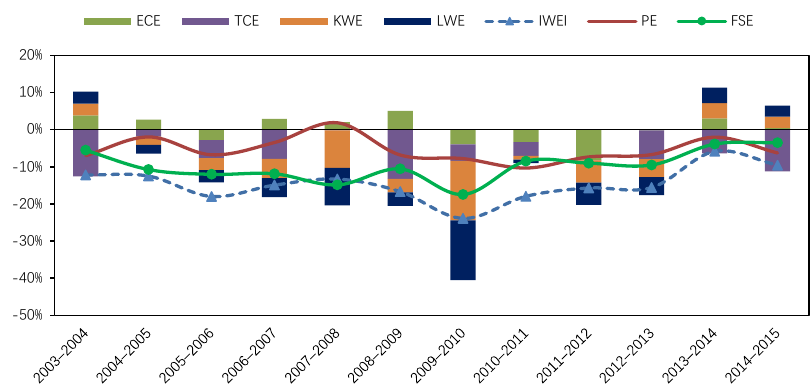
Figure B6. Driving factors of industrial wastewater emission intensity change in the Middle Reaches of the Yangtze River, 2003 – 2015. ECE: the effect of technical efficiency change; TCE: the effect of technological change; KWE: the effect of capital – wastewater substitution; LWE: the effect of labor – wastewater substitution; IWEI: industrial wastewater emission intensity; PE: productivity effect; FSE: factor substitution effect.